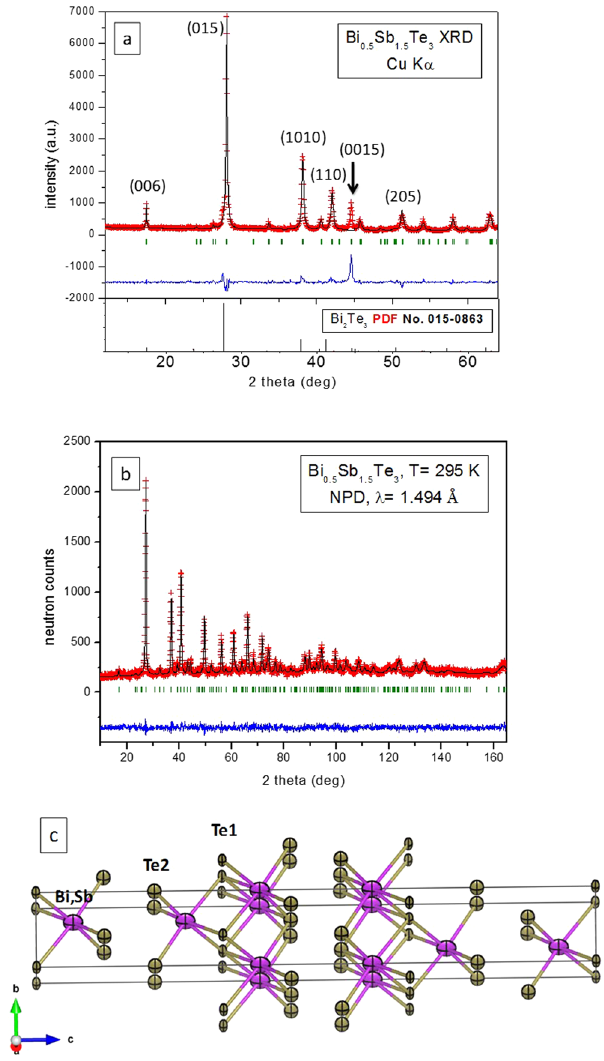
Figure 1. Structure and morphology of Bi 2 − x Sb x Te 3 (data shown for x = 1.5) ( a ) XRD and ( b ) NPD patterns at room temperature for the same sample. Rietveld-refinement in the space group R-3m of the XRD is hindered by strong preferred orientation that enhances the [00l] reflections (see for example the [0015] reflection). The NPD pattern is well refined with observed (crosses), calculated (full line) and difference (at the bottom) profiles. ( c ) Representation of the layered crystal structure. The anisotropic displacement ellipsoids (drawn with 95% probability) are flattened along the [110] direction, as determined from NPD Rietveld refinement.